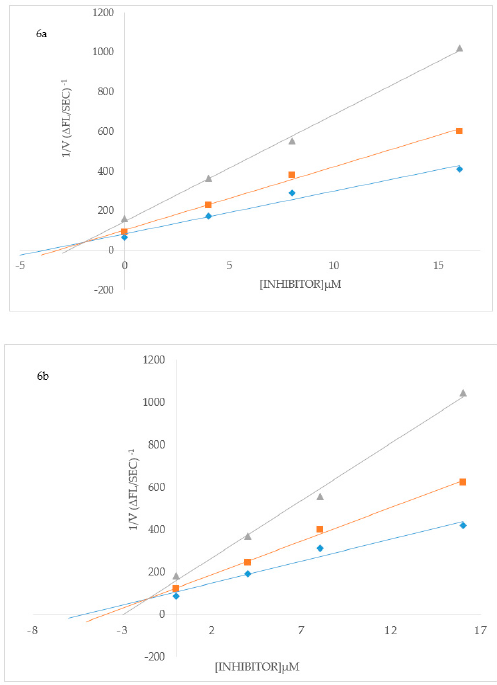
Figure 6. Dixon plots for inhibition of BACE ‐ 1 by 2j (Figure 6a) and 3l (Figure 6b), respectively. Blue symbols and fitted straight lines represent enzyme activity in the presence of 450 nM substrate and orange and grey, 300 nM and 150 nM substrate, respectively.